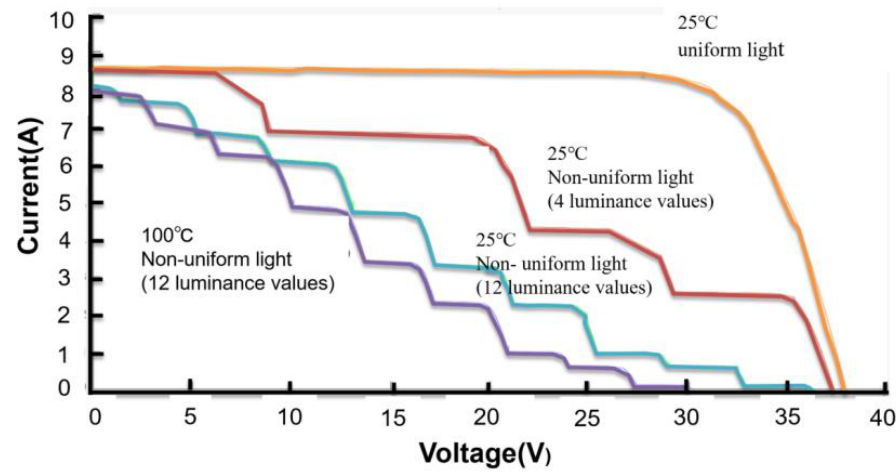
Figure 7. V – I curve at different temperatures. To verify the simulation results, a multi-wavelength experimental platform was built. In this platform, 36 polycrystalline silicon cells of 70 mm × 70 mm × 3 mm were used, which were spliced into a photovoltaic panel of 420 mm × 420 mm to receive laser light. The photovoltaic panel area is 0.1764 m 2 , as shown in Figure 8.